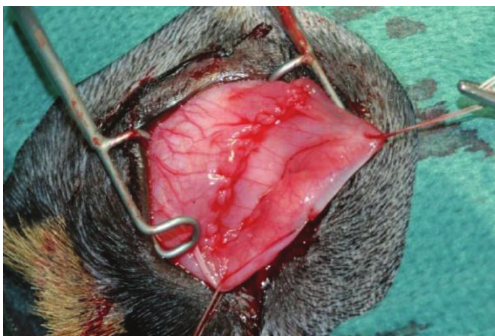
Figure 5: Closure of the conjunctiva above the